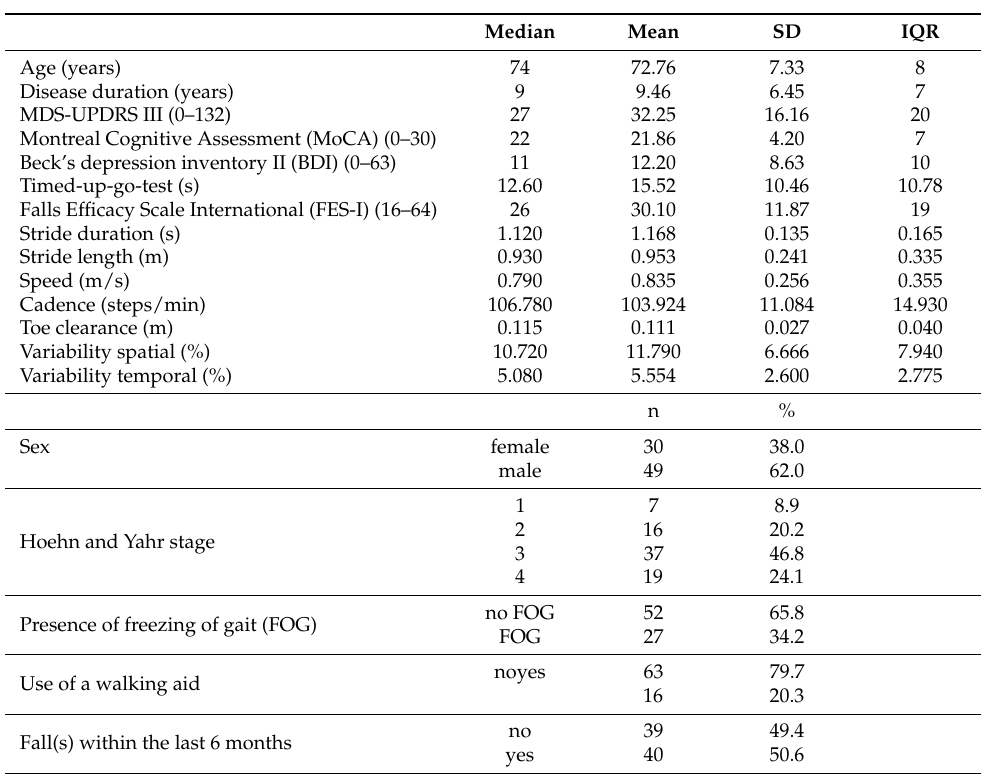
Table 2. Demographical and clinical characteristics of the entire cohort (N =